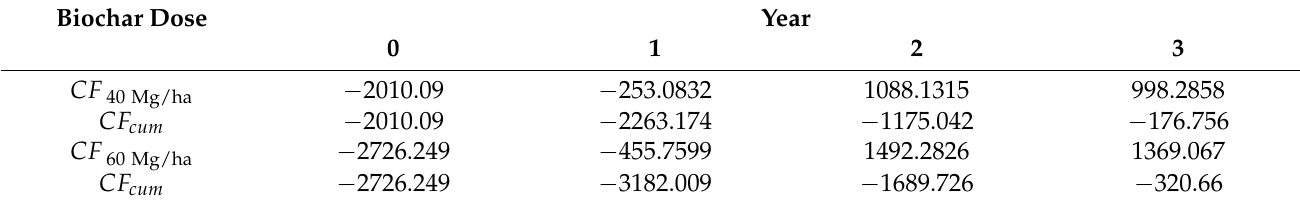
Table 4. Payback period for biochar doses of 40 Mg/ha and 60 Mg/ha calculated for the three-year period (t), at a discount rate of 9% per